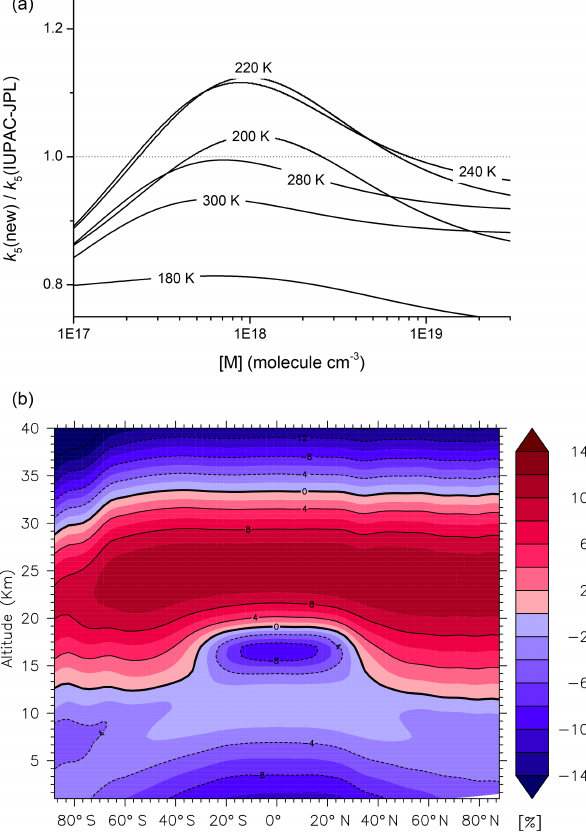
Figure 11. (a) Ratio of rate coefficients obtained by combining results from this work with selected data sets from the literature, k 5 (new), to those presently recommended by the IUPAC and JPL panels, k 5 (IUPAC-JPL). (b) Change in rate coefficient k 5 (new) compared to previous IUPAC and JPL evaluations. The percentage change was calculated using annually and zonally averaged temper- atures and pressure in the EMAC